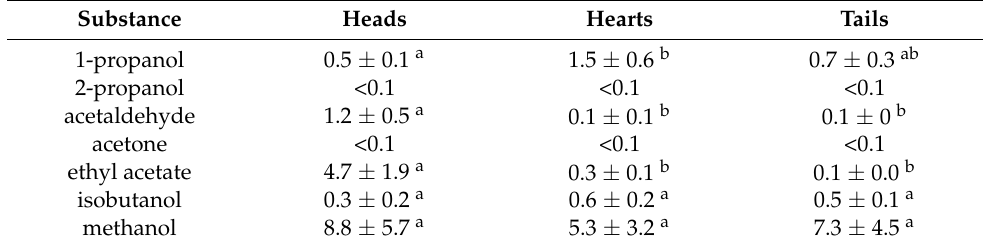
Table 3. Volatiles in distillate fractions of mashes No. 1–10.